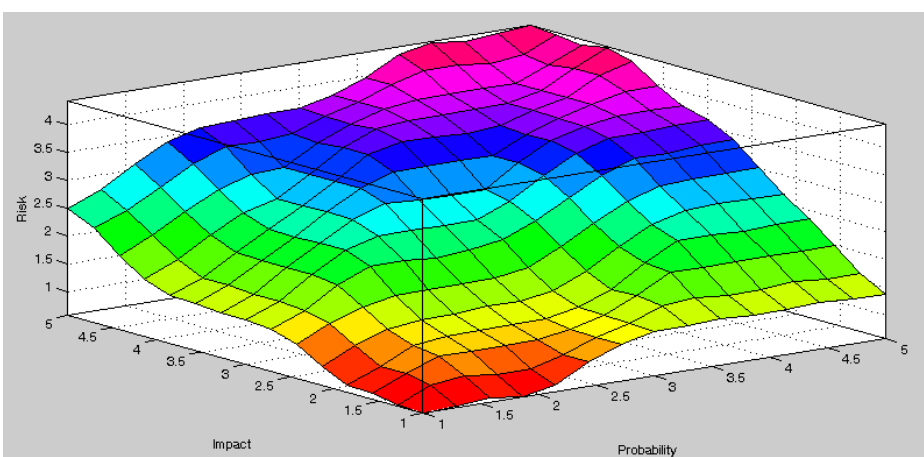
Fig. 10. Control surfaces of the inputs